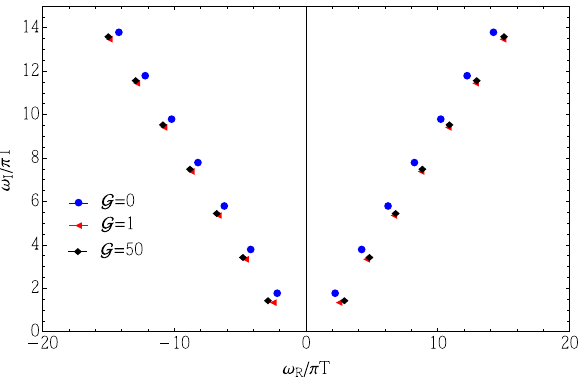
Fig. 10 The numerical results obtained using the pseudo-spectral method for selected values of the parameter G